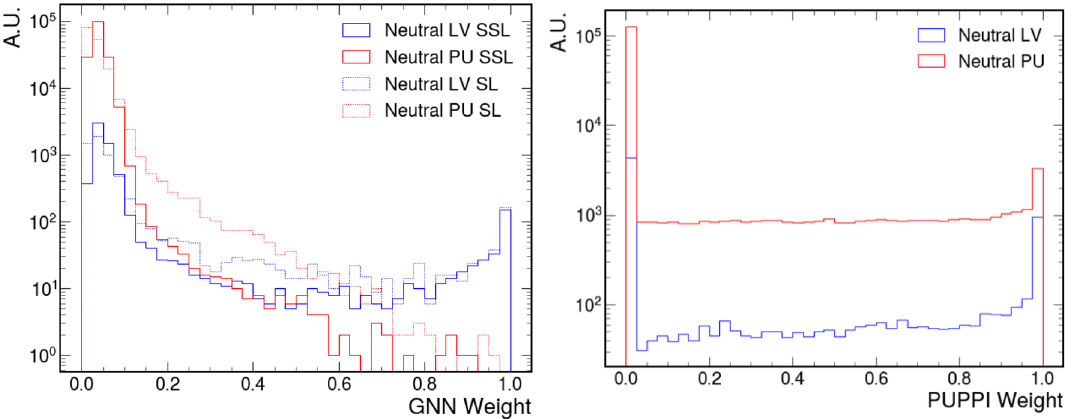
Fig. 9 GNN weight (left) and PUPPI weights (right) on neutral